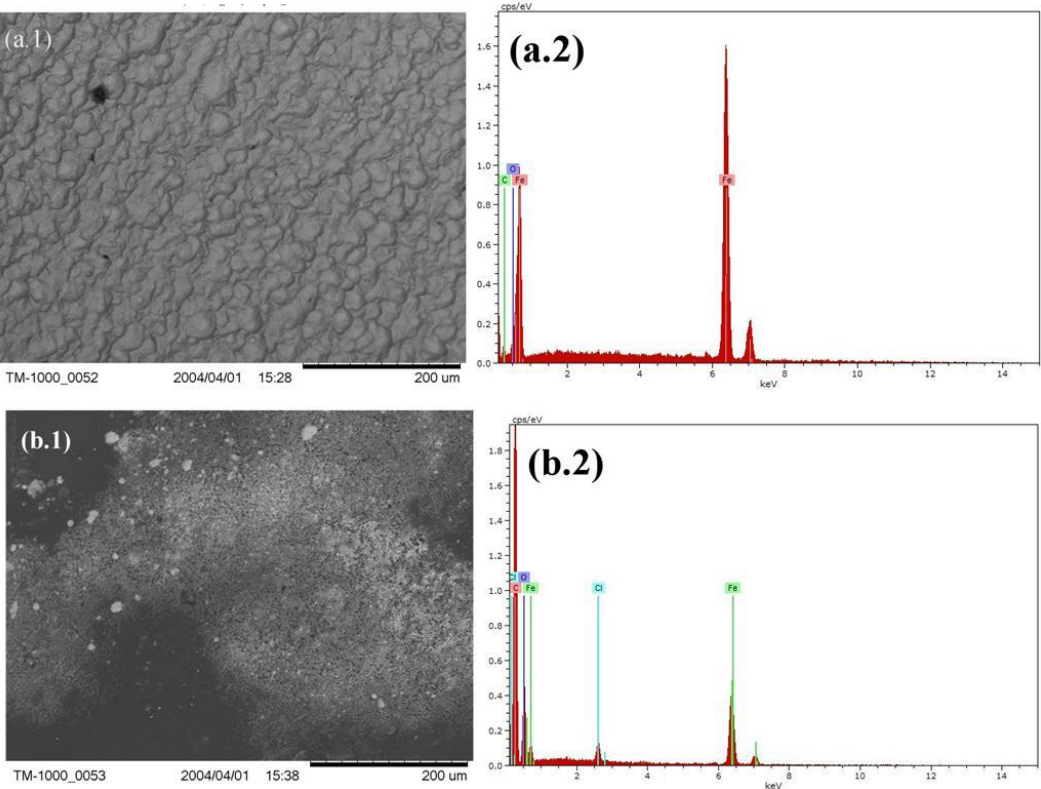
Figure 11. SEM and EDX of API P110 carbon steel after the 24-h immersion test in 1 M HCl at 333 K, without (a.1-a.2) and with 3.5% v/v of P10